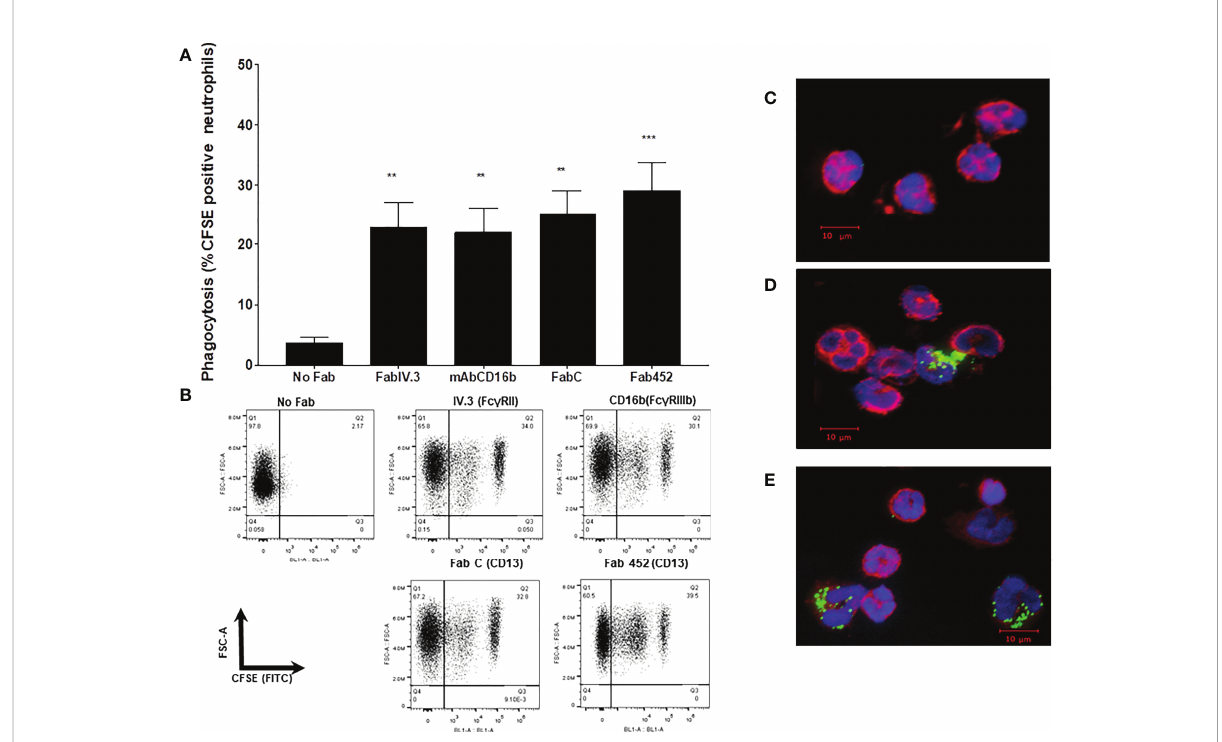
FIGURE 2 CD13 mediates phagocytosis in human neutrophils. Neutrophils were incubated with either Fab fragments of IV.3 (anti-Fc g RII), mAb anti-CD16b (anti-Fc g RIIIb), Fab C or Fab 452 (anti-CD13), or without antibody (No Fab), and phagocytosis of CFSE-labeled EBS-Fab was determined as described in materials and methods. (A) Average CFSE-positive cells from 11 independent experiments with cells from different donors. Bars represent the mean(±SEM) percentage of CFSE positive cells. ** p <0.01, *** p <0.001, relative to No Fab. (B) Representative dot plots of a single experiment after incubation at 37°C and lysis of non-internalized erythrocytes. FSC-A: Forward-scatter-area. (C-E) Representative immuno fl uorescence images of cells after phagocytosis for 1 h, fi xation and staining with phalloidine-rhodamine (red) and DAPI (blue); C: No Fab, D: Fab C, E: Fab